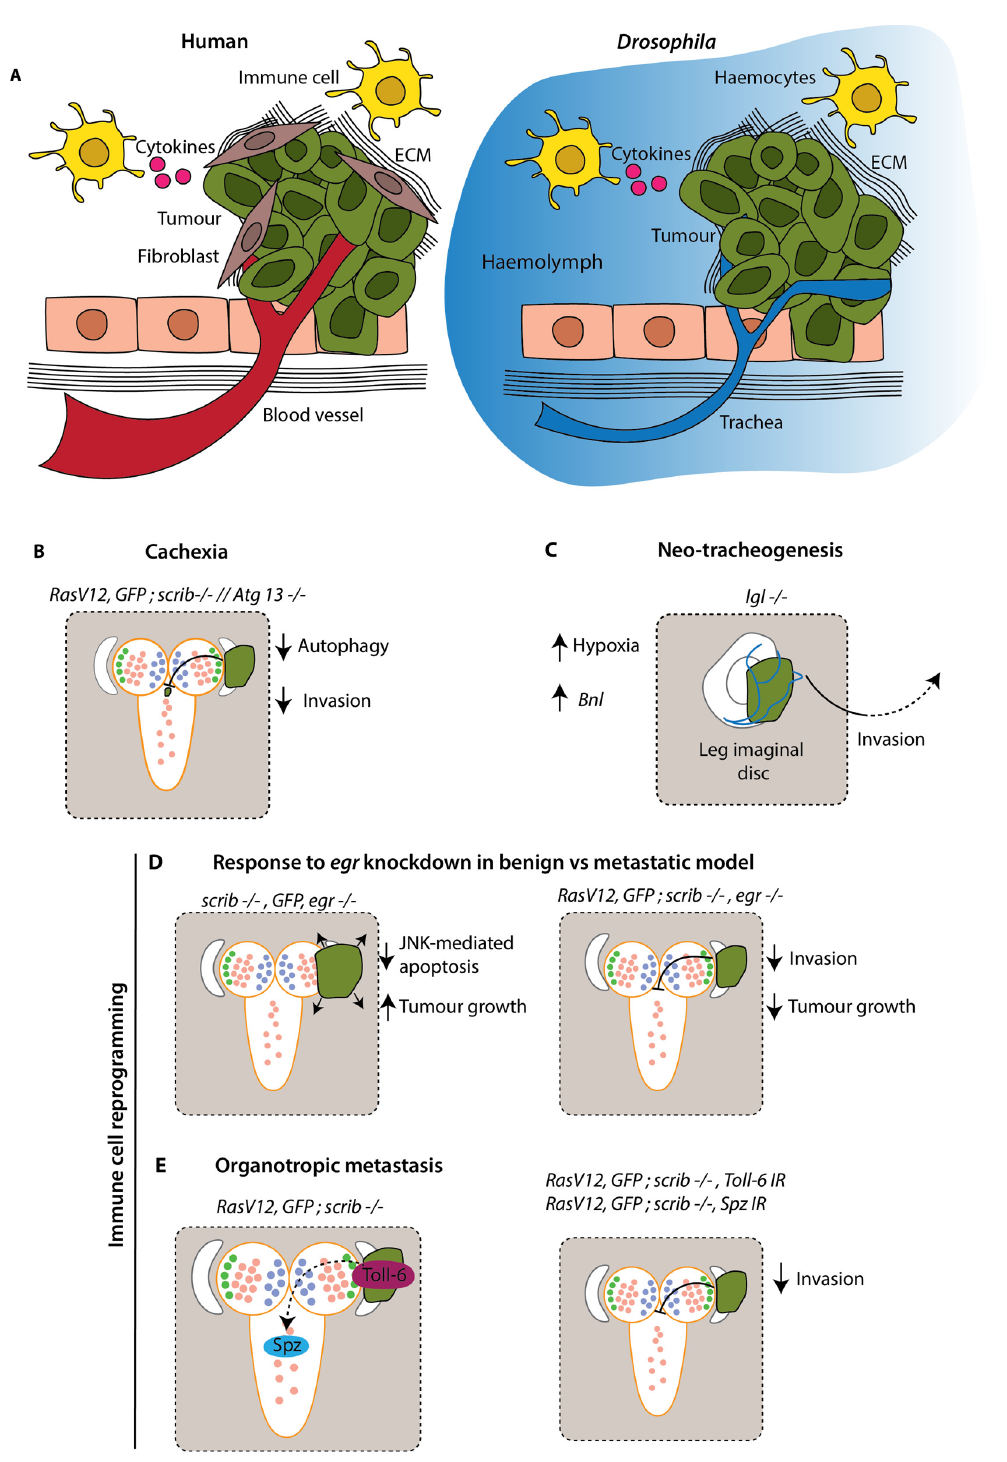
Figure 3. Modelling the influence of the tumour microenvironment in Drosophila larvae. ( A ) Key aspects of the tumour microenvironment in humans vs. Drosophila . The microenvironment includes fibroblasts, which secrete ECM and other factors to drive tumour growth and metastasis; immune cells, which can secrete cytokines and create an inflammatory environment; and blood vessels, which are recruited by the tumour and provide oxygen and nutrients to promote growth. Drosophila lack a closed circulatory system; their tissues are bathed in haemolymph and trachea supply oxygen. In the absence of an adaptive immune response and a vast array of immune cells, Drosophila rely on innate immune responses. In epithelia, wounds activate JAK/STAT and JNK signalling pathways